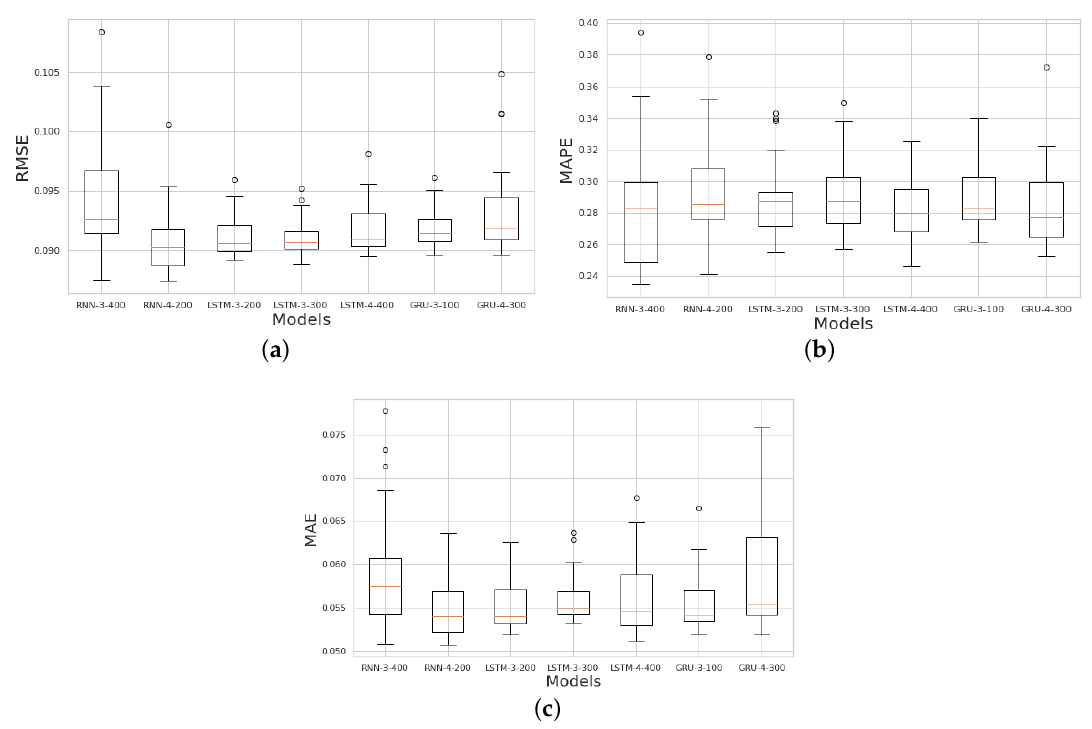
Figure 12. Boxplot of ( a ) RMSE , ( b ) MAPE , and ( c ) MAE regarding the best deep learning